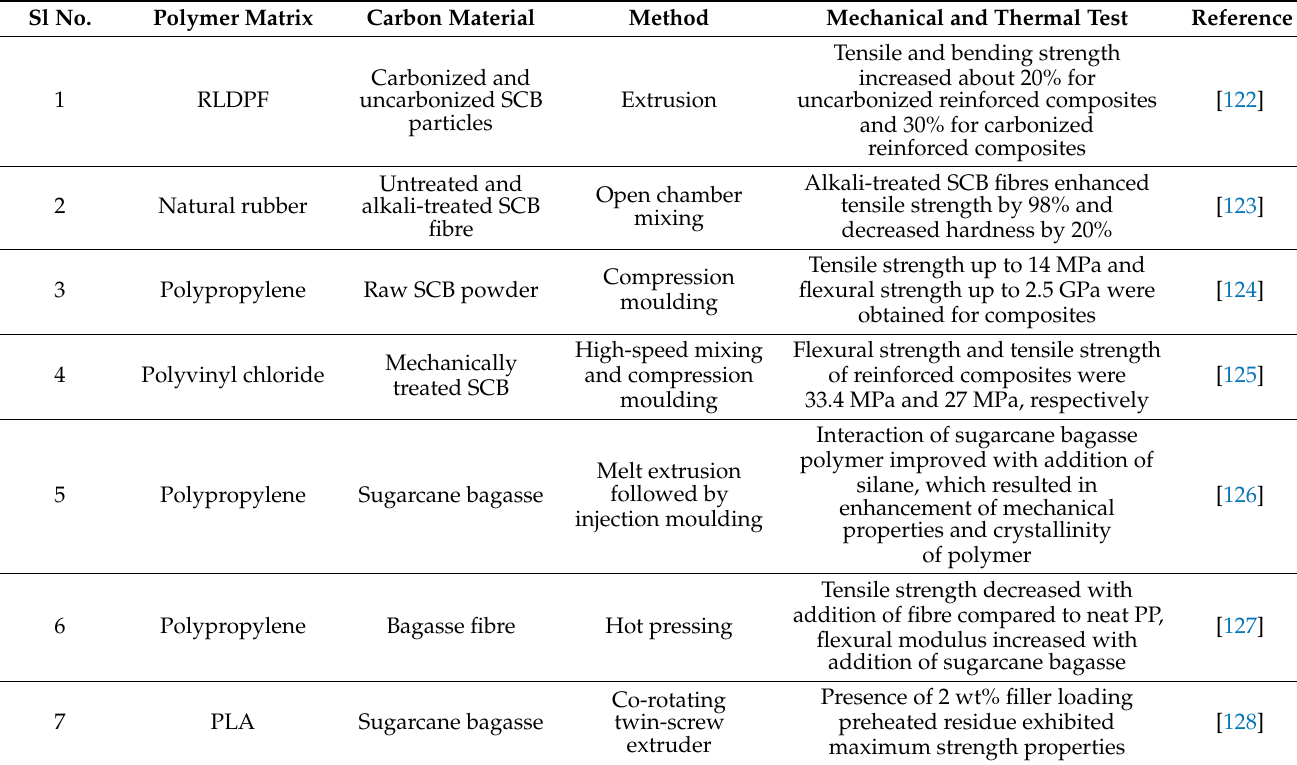
Table 10. Synthesis and characterization of sugarcane bagasse